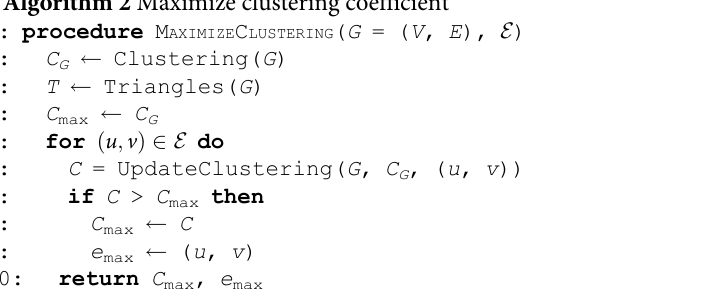
Algorithm 2 iterates over all potential links, uses Algorithm 1 to update the clustering coef- ficient and returns a link that yields the maximum clustering coefficient. As Algorithm 1 with input ( u , v ) returns the clustering coefficient of the extended network G + uv , and Algorithm 2 iterates over all potential links, it returns an optimal solution of Problem 1 for m = 1 in Þ , where d is the maximum degree of the nodes in V O ð n o þ j E j d max max